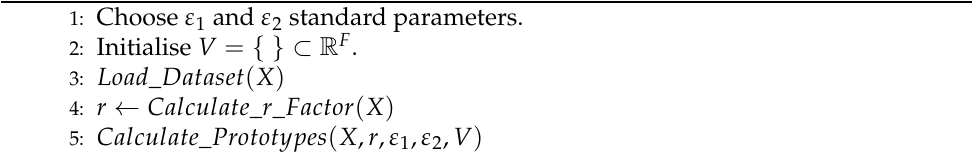
Algorithm 3: Pseudocode for the FM algorithm, V is the algorithm output that contains the prototypes found by the clustering process. F is the dimension of the vector